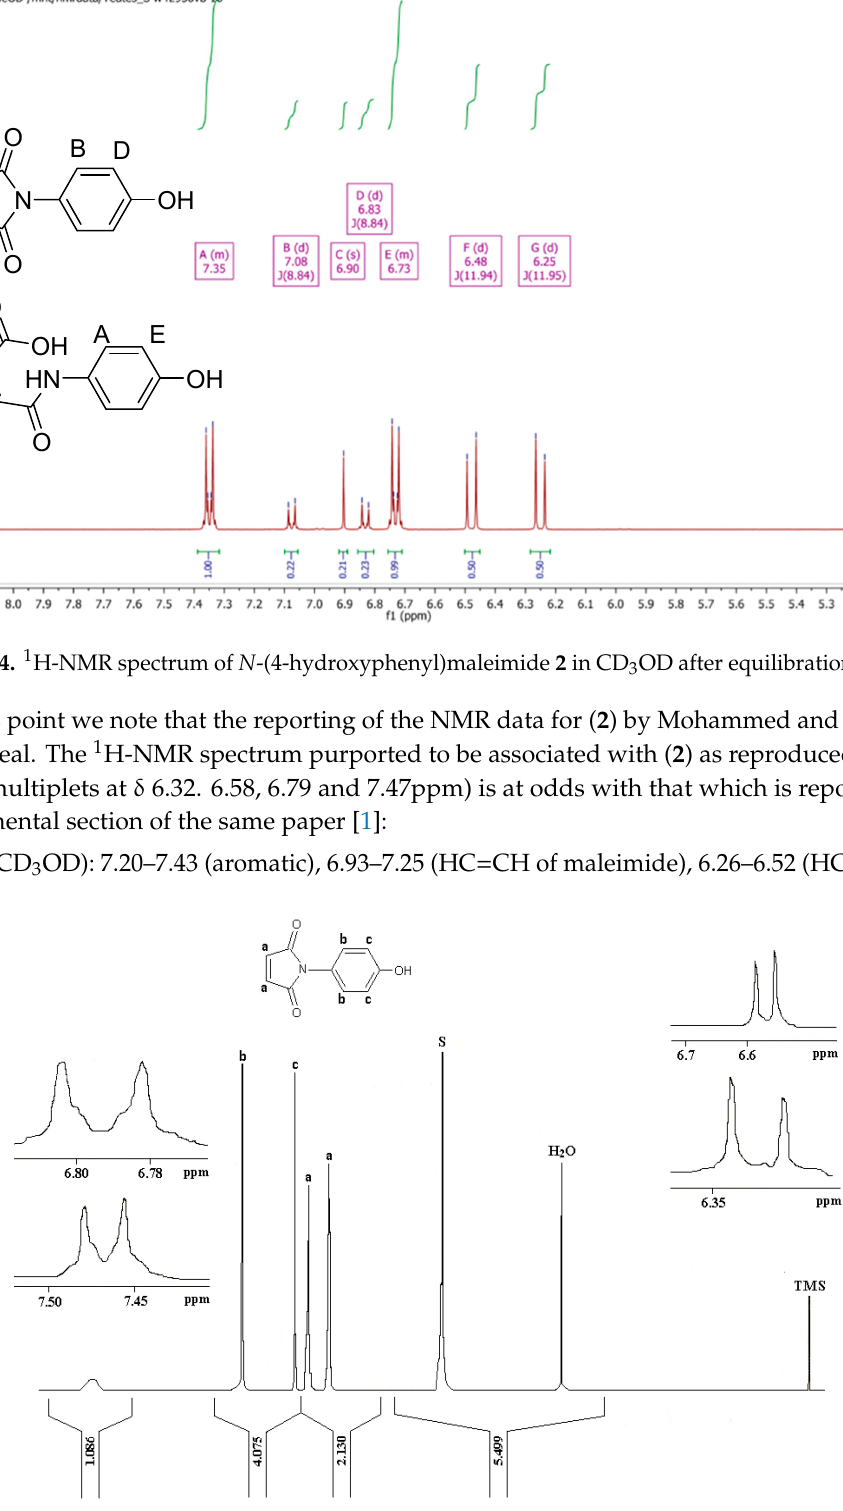
Figure 5. 1 H-NMR data for N -(4-hydroxyphenyl)maleimide ( 2 ) in CD 3 OD as reported by Mohammed and Mustapha [1].